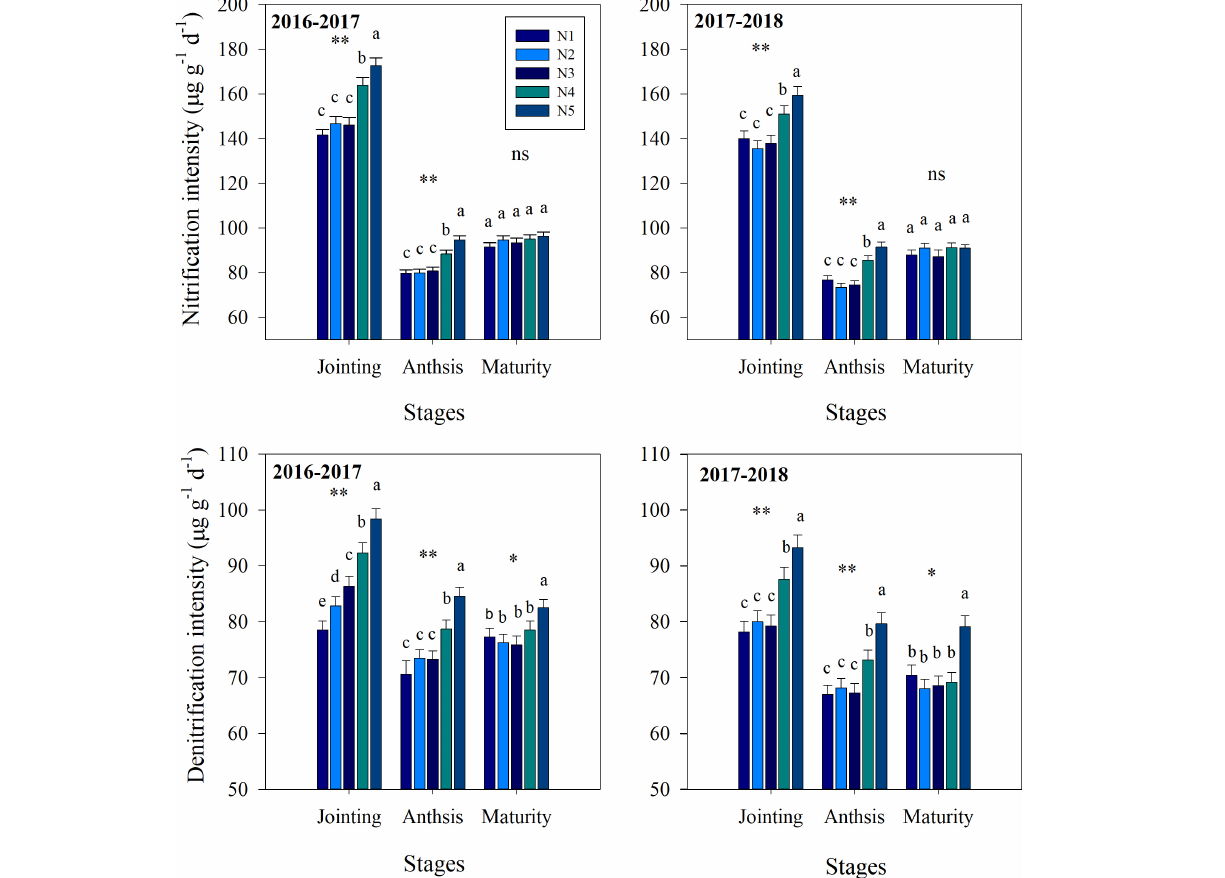
Frontiers in Plant Science |